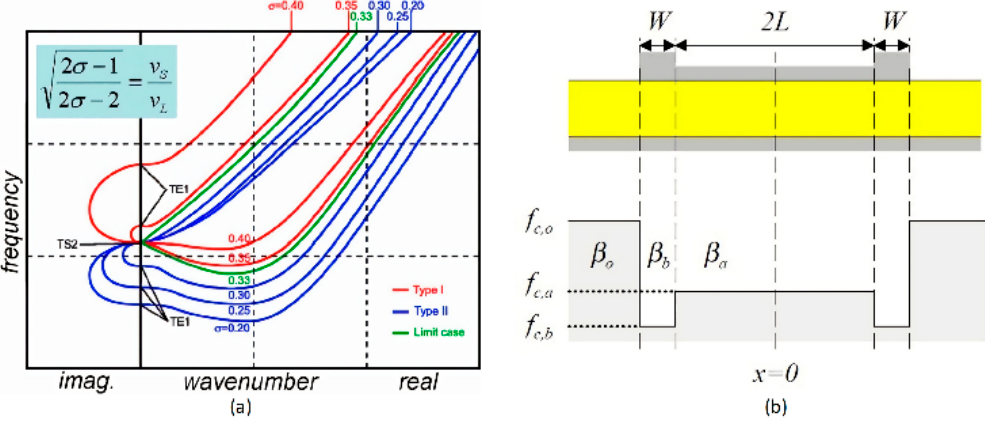
Figure 11. ( a ) Influence of the Poisson ratio onto the dispersion type of a BAW resonator. Poisson ration is used to correlate the longitudinal wave velocity and the shear wave velocity of the material, reproduced with permission from [85]. ( b ) The structure of suppression of the type I resonator and the cut ‐ off frequency diagram, reproduced with permission from [14].